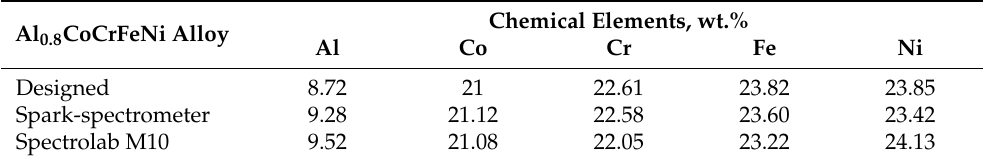
Table 1. Chemical composition of the experimental HEA: designed and determined by analysis. Chemical Elements, wt.% Al 0.8 CoCrFeNi Alloy Al Co Cr Fe Ni Designed 8.72